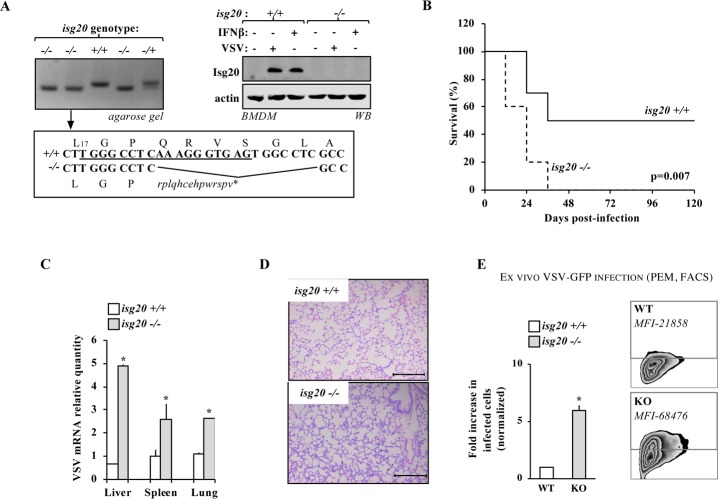
Isg20 -/- mice exhibit higher susceptibility to VSV infection.A) CRISPR/Cas9 was used to generate a functional ISG20 knockout mouse. The target sequence is underlined and the resulting indel mutation and downstream open reading frame, as well as corresponding PCR in founders, are shown. To detect ISG20 protein, bone marrow-derived macrophages were stimulated either with IFN β or with VSV for eight to twelve hours prior to WB analysis. B) isg20-/- and +/+ age- and sex-matched littermates were intraperitoneally infected with VSV. The graph presents survival rates of each group. C) The extent of VSV replication in the indicated tissues was determined by RT-qPCR. D) Representative lung sections are shown upon hematoxylin and eosin staining that preferentially label inflammatory cells. E) Peritoneal macrophages (PEMs) were prepared from isg20 -/- or control mice and then challenged ex vivo with VSV-GFP (MOI 0.5) prior to flow cytometry analysis twenty-four hours later. A representative zebra plot is shown with respective MFI of GFP-positive cells. The graphs present Means and SEM of three independent experiments (20 animals in two independent experiments in survival experiments).